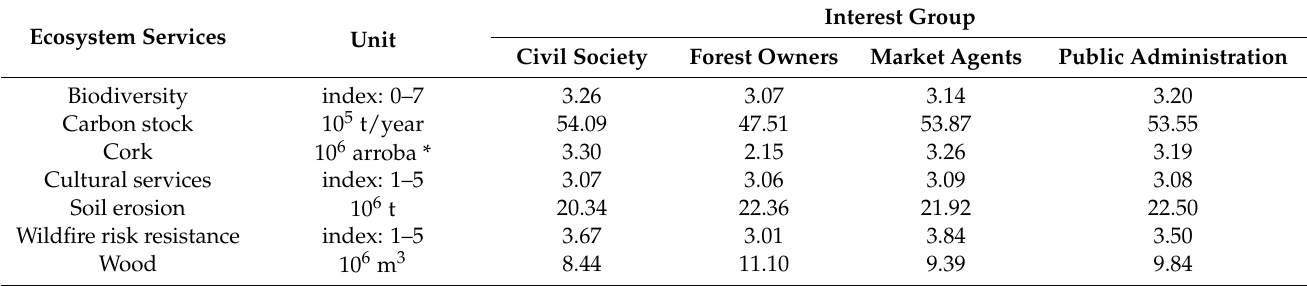
Table 4. Consensual Pareto frontier solutions for a 90-year period, by interest